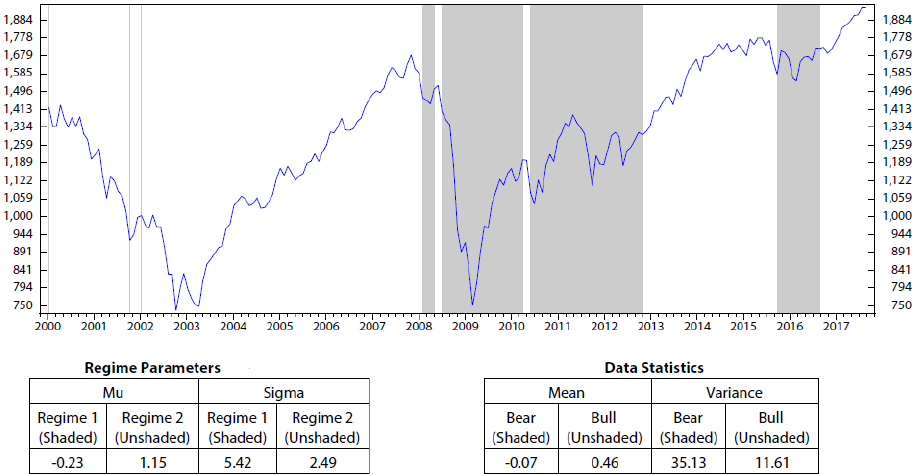
Figure A4. The MSCI World index and its regimes detected using HMM for monthly data from 31 December 1999 to 31 August 2017. Regime 1 and regime 2 correspond to the Bear and Bull markets,